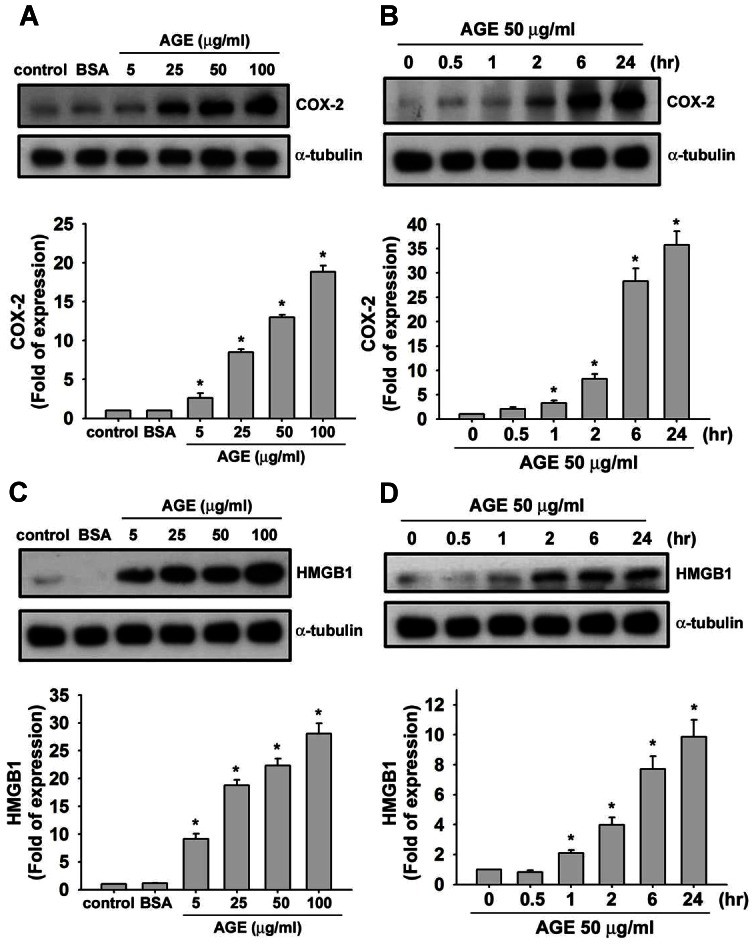
AGEs induce inflammatory signalings in human OA chondrocytes.Human OA chondrocytes (1×106/ml) were incubated with AGEs (5–100 µg/ml) for 24 hours (A, C) or 0.5–24 hours (B, D). Protein expressions of COX-2 (A, B) and HMGB1 (C, D) were determined by Western blotting. Densitometric analysis for COX-2 and HMGB1 levels corrected to α-tubulin is shown. All data are presented as mean ± SEM for three independent experiments. *: P<0.05 versus control.